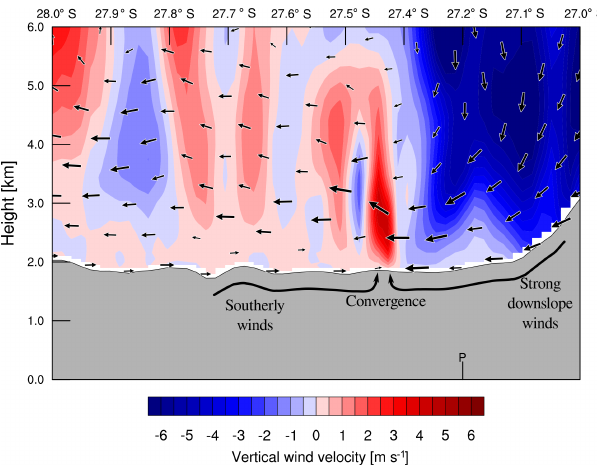
Figure 13. Meridional cross section of vertical velocity on 13 June at 16:00UTC according to 2km WRF-ARW output. As a result of orographic effects, intense ascending airflows driven by horizon- tal convergence occurred in Fiambalá Basin, between 27.5 ◦ S and 27.4 ◦ S (longitude: ∼ 67.7 ◦